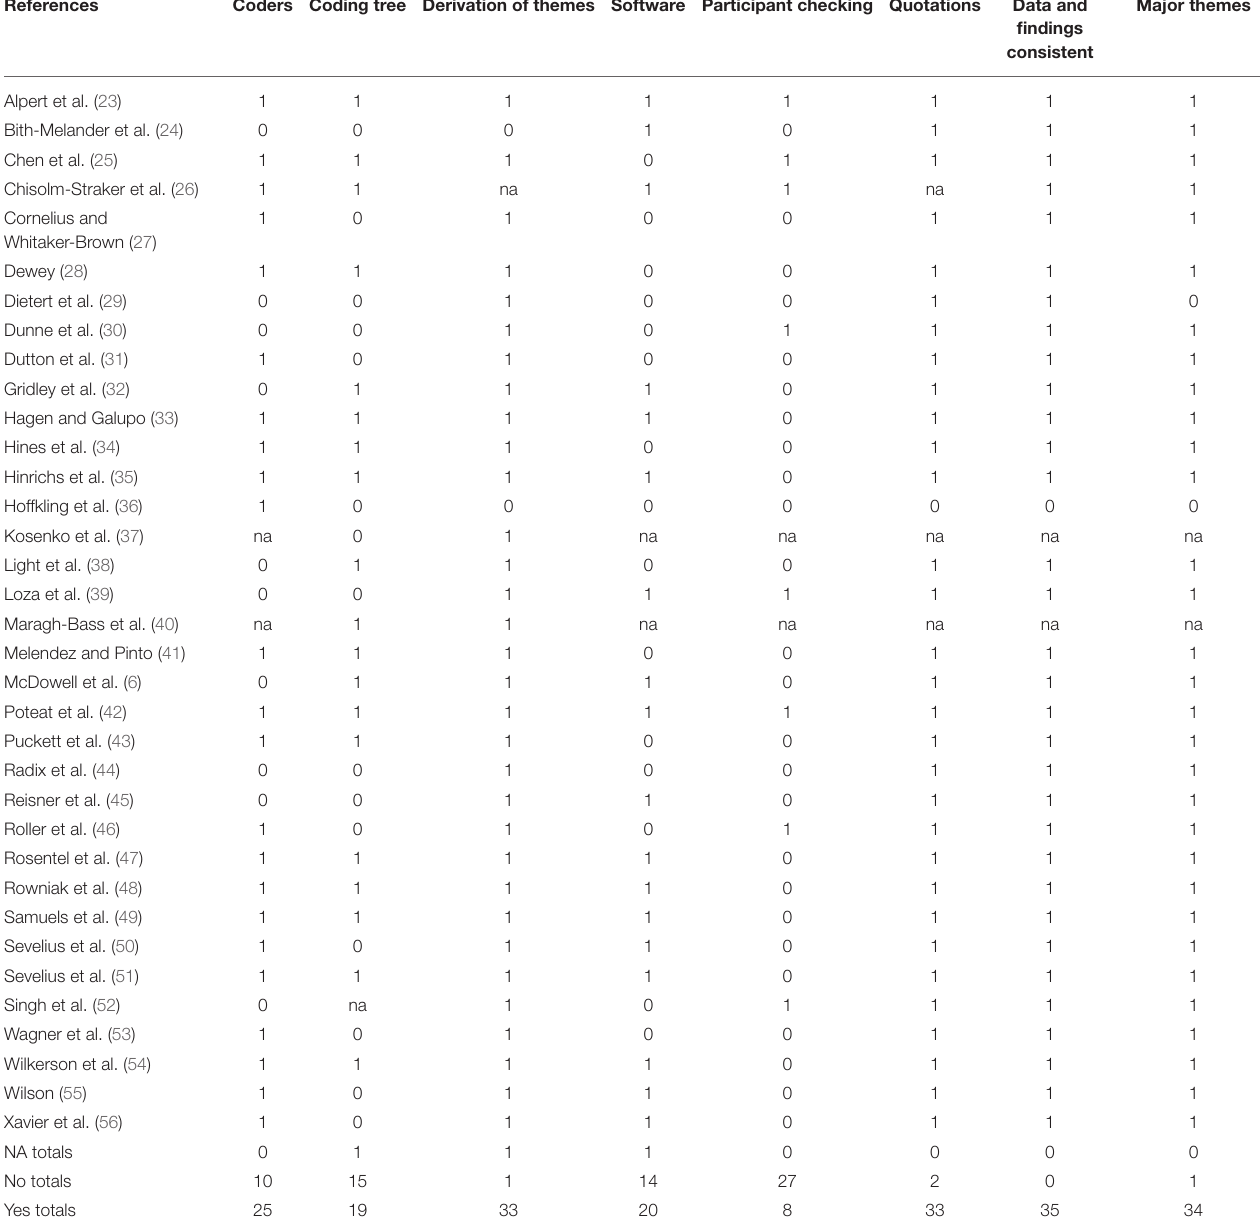
TABLE 6 | COREQ domain 3: analysis and findings.